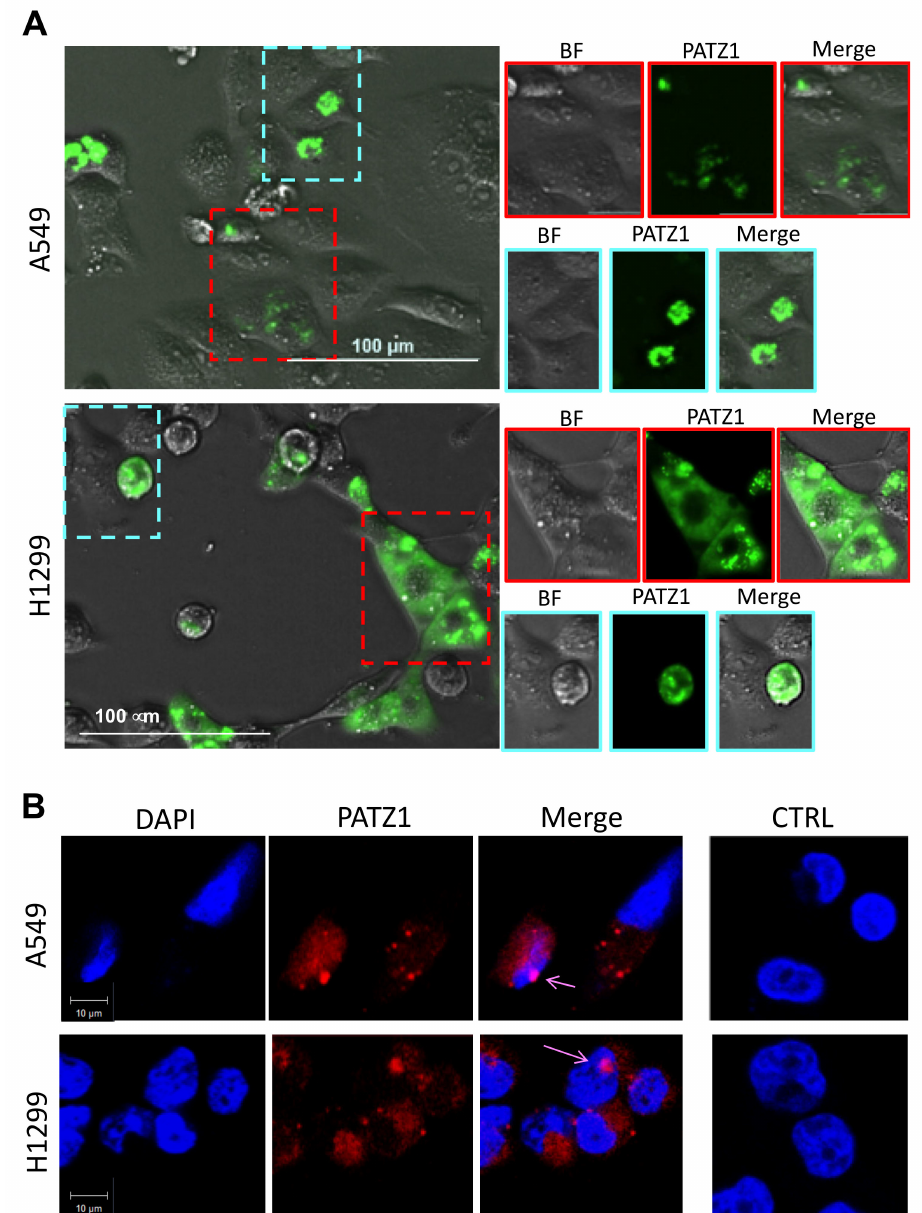
Figure 6. PATZ1 subcellular distribution in A549 and H1299 transfected cells. ( A ) Fluorescent microscopy in living cells showing the merging images of green fluorescent PATZ1 protein and bright field. Dotted frames enclose cells in which PATZ1 expression appears localized in the nucleus (cyan) or cytoplasm (red). Outsets on the right report each single bright field (BF), green (PATZ1) and merge image of the insets. Scale bar: 100 µ m. ( B ) Representative confocal fluorescence images on PFA-fixed cells stained with DAPI. Single fluorescence detection of either DAPI (blue) or PATZ1 (red) and digital merge of the images are shown. Colocalization (pink) of PATZ1 and DAPI is indicated by arrows. Negative control (CTRL) represented by untransfected cells is shown on the right. Scale bar: 10 µ